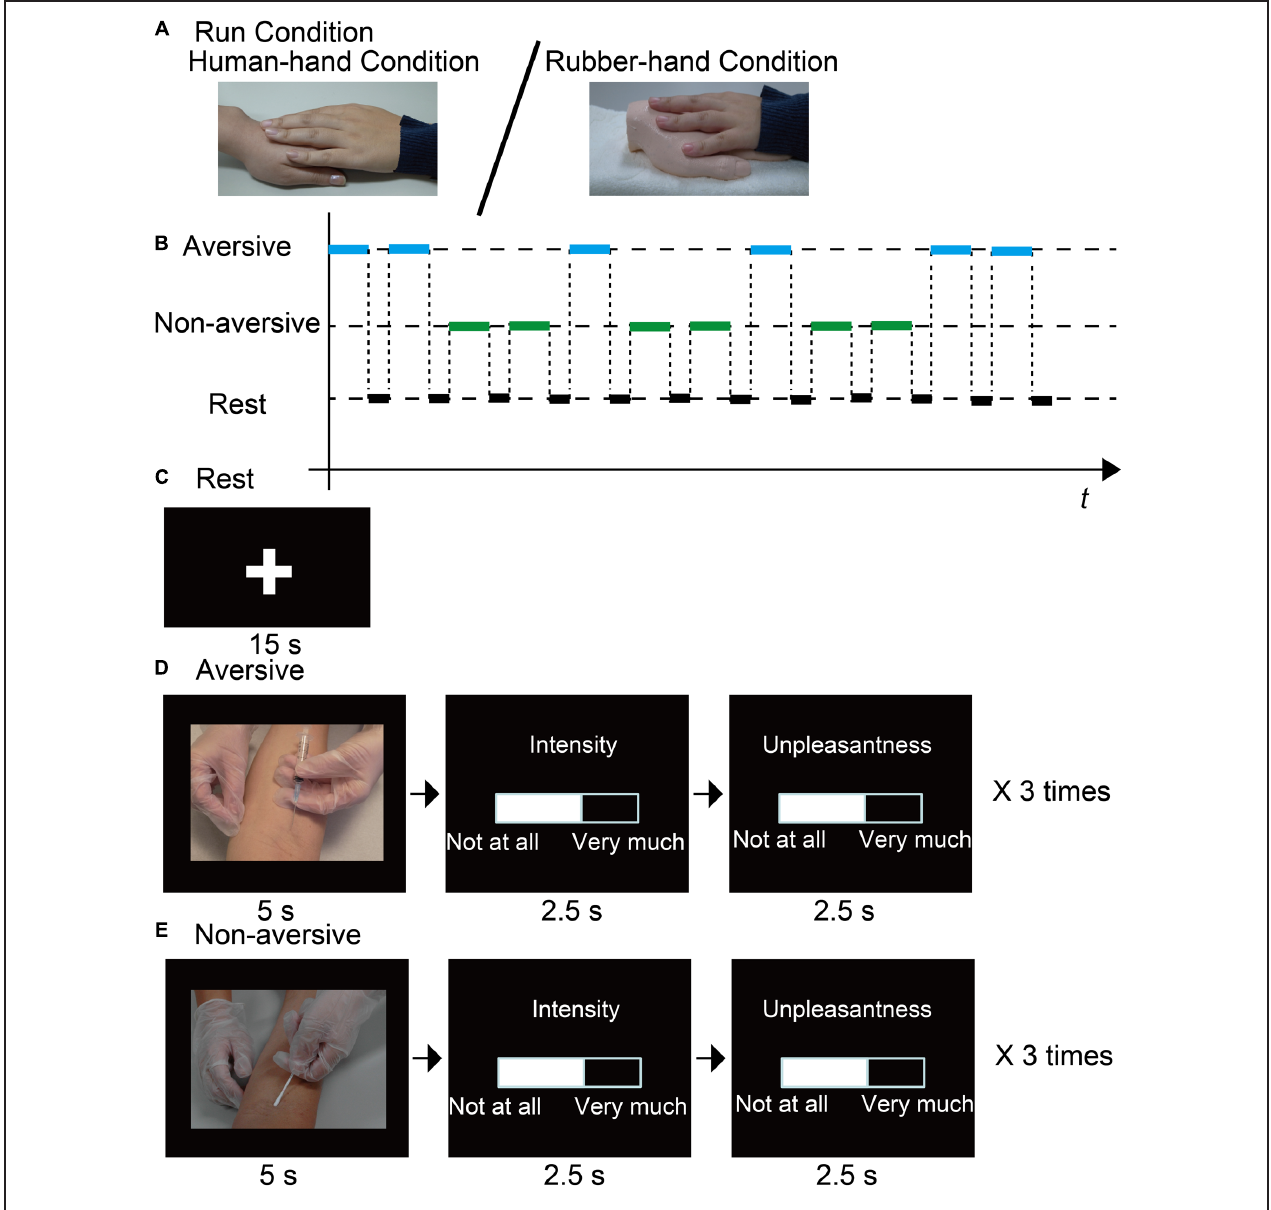
FIGURE 1 | Outline of experiment. (A) Participants joined hands with a close friend or a rubber hand. (B) Example of a time chart of visual stimuli presentation sequence. (C) In between stimulus blocks, a fixation cross was presented at the center of the screen for 15 s.